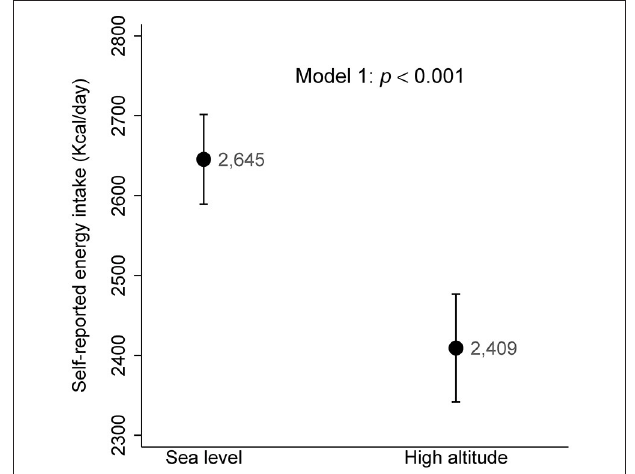
FIGURE 3 | Self-reported energy intake according to the altitude of residence. ANCOVA multivariate Model 1 adjusted for: age, sex and residence